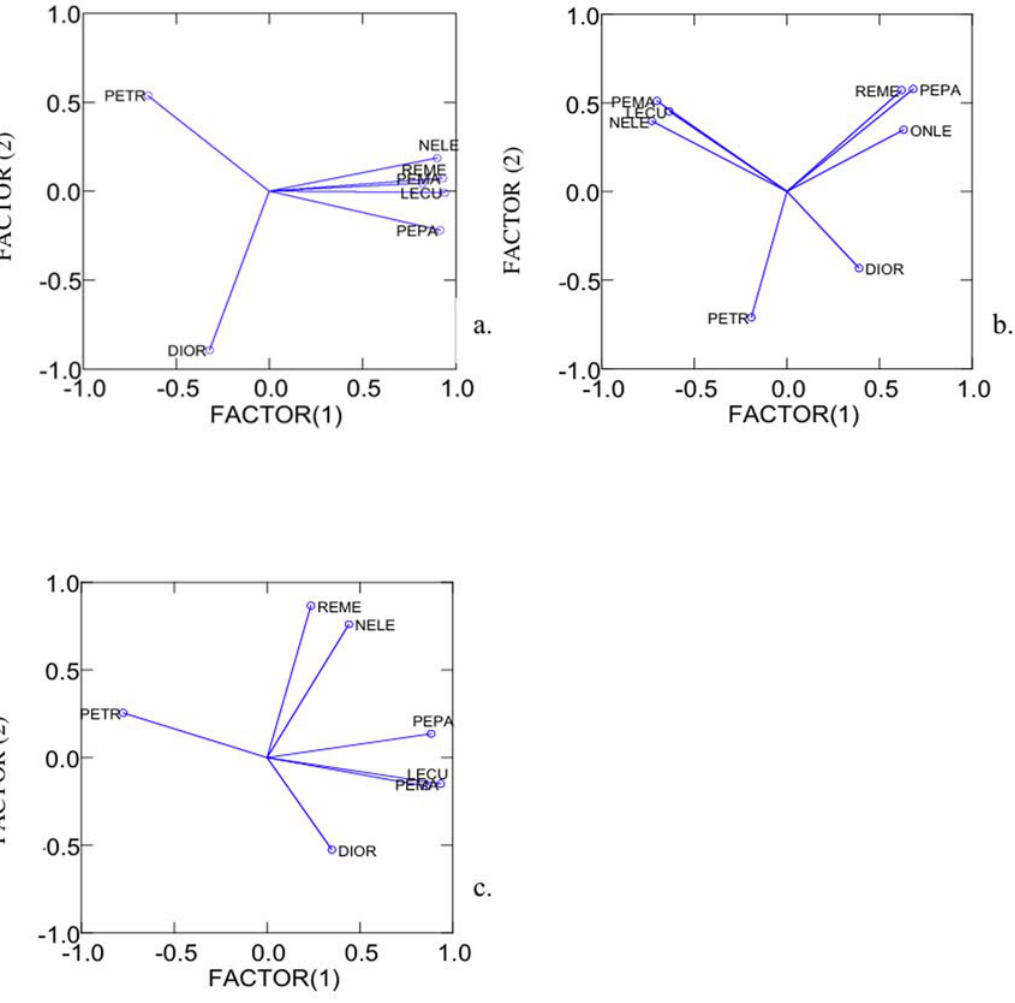
Figure 1. Principle components analysis (PCA) of rodent communities grouped by mean SNV prevalence. Total number of individuals of each species was entered as components. Factor loadings plots were standardized to two factors. Figure 1.a. Factor loadings plot for low (0–5%) prevalence communities. Figure 1.b. Factor loadings plot for moderate (7–14%) prevalence communities. Figure 1.c. Factor loadings plot for high ( . 17%) prevalence communities. PEMA=deer mouse, PETR=pinyon mouse, DIOR=Ord’s kangaroo rat, NELE=desert woodrat, REME=western harvest mouse, PEPA=Great Basin pocket mouse, ONLE=Northern Grasshopper mouse.